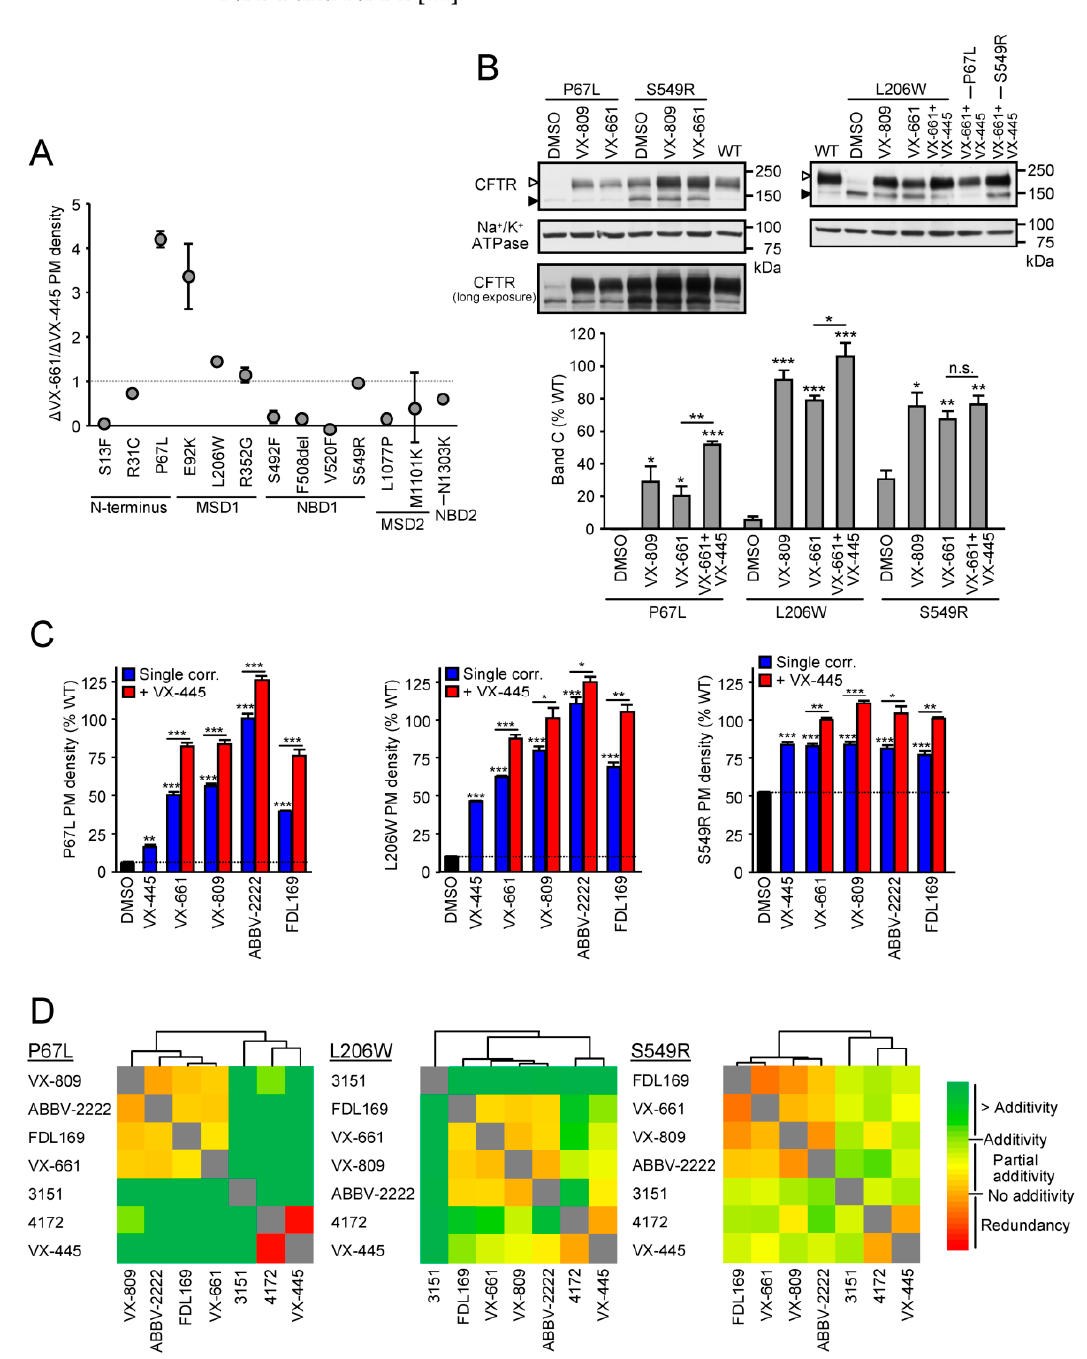
Figure 1. P67L-, L206W- and S549R-CFTR are highly responsive to type I correctors. ( A ) Ratio of the relative responsiveness of the indicated CFTR mutants expressed in CFBE to VX-661 (3 µ M, 24 h, 37 ◦ C) and VX-445 (2 µ M, 24 h, 37 ◦ C) determined by PM density measurement ( n = 3). The variable absolute responses to single correctors expressed as percentage of WT-CFTR PM density are depicted in Supplementary Figure S1A. ( B ) Immunoblot (upper panel) of CFBE expressing inducible CFTR mutants with an extracellular 3HA tag. The cells were incubated for 24h with DMSO, VX-809 (3 µ M), VX-661 (3 µ M) or VX-661 + VX-445 (2 µ M). CFTR was visualized with anti-HA antibody, and anti-Na + /K + -ATPase served as loading control. The empty arrowheads indicate the mature, complex-glycosylated CFTR (C-band), and the filled arrowhead show the immature, core-glycosylated protein (B-band). The the complex-glycosylated form (band C, lower panel, n = 3) was quantified by densitometry and, after normalization for CFTR mRNA abundance, is expressed as percentage of WT-CFTR. To visualize the low abundance of uncorrected P67L band C, a longer exposure is shown. ( C ) PM density of CFTR mutants after type I corrector (VX-661, VX-809, ABBV-2222 or FDL169–3 μ M, 24 h, 37 °C), VX-445 (2 μ M, 24 h, 37 °C) or type I + VX-445 corrector combination treatment expressed as percentage of WT-CFTR in CFBE ( n = 3). ( D ) Heat map of the combinatorial profiling for P67L-, L206W- and S549R-CFTR established by calculating the dual cor- rector effect in relation to the theoretical additivity of the compounds. Combinatorial profiles were subsequently used to cluster compounds by average linkage analysis and the distance was determined by Spearman`s rank correlation. The